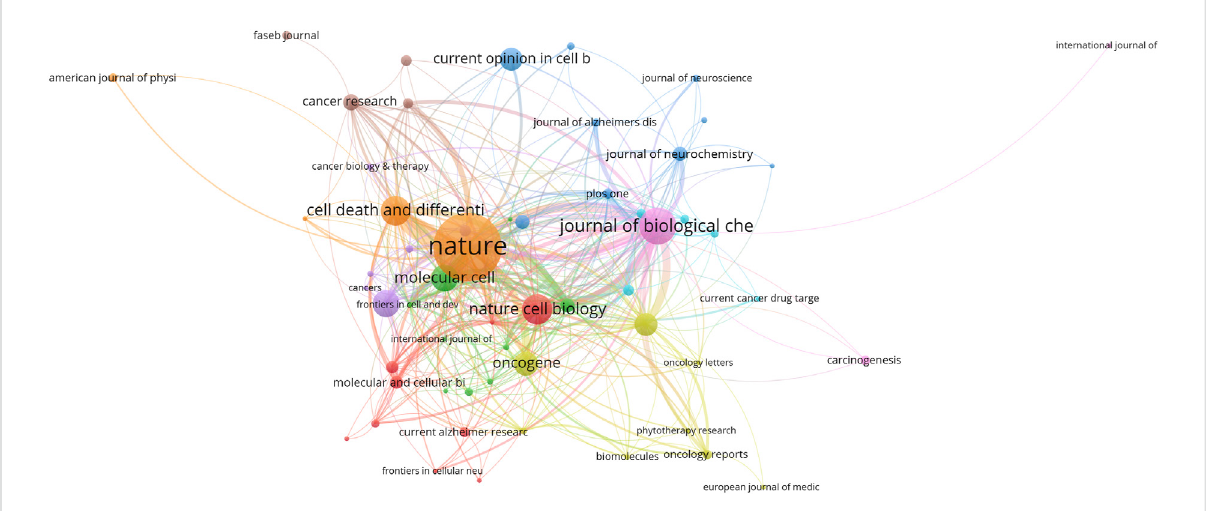
FIGURE 6 Journals with occurrence relations shown as an overlay graph plotted with VOSviewer 1.6.14. The analysis method is Linlog/modularity. The Weights was citations. The width of the line indicates the strength of the relationship.